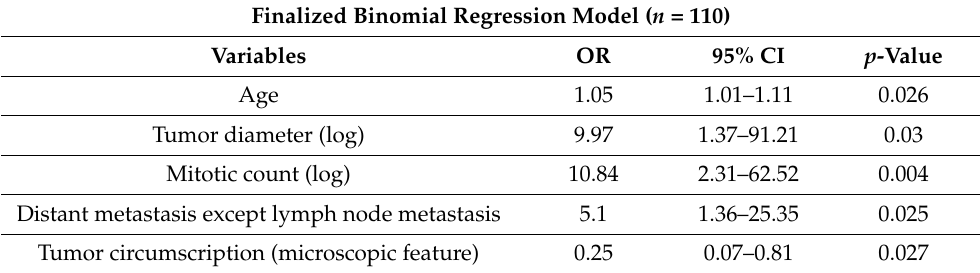
Table 4. Final binomial regression prediction model ( n =